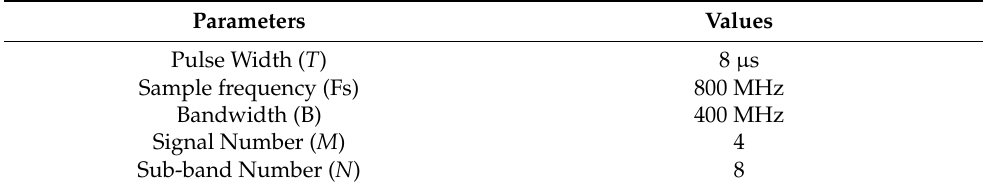
Table 1. MIMO radar system